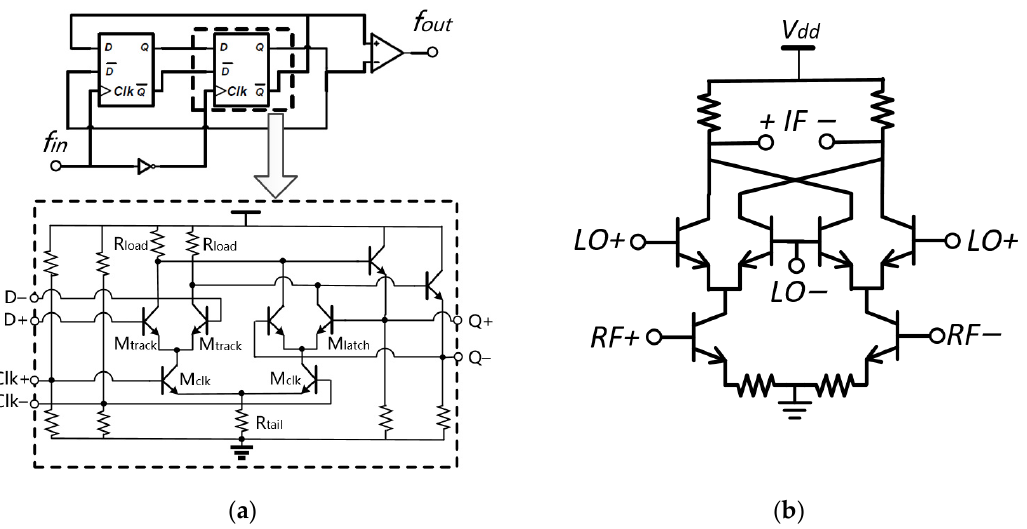
Figure 5. Schematic of ( a ) the CML divide-by-2 divider; ( b ) the double-balanced mixer core with resistively degeneration.